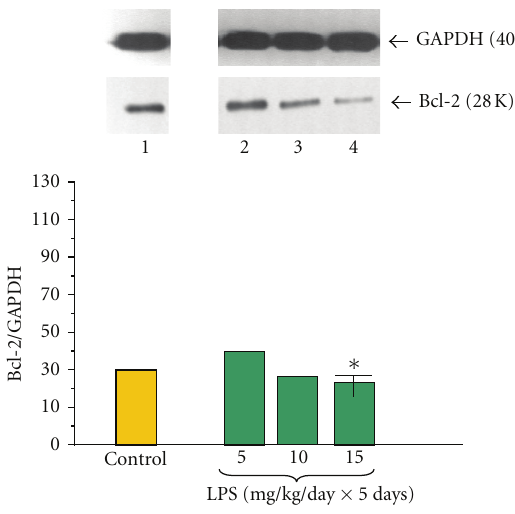
Figure 2: Western blot analysis of TLR4 protein level in the adult rat pancreatic acinar cells under basal conditions (lane 1), stimulated in vitro by caerulein at the dose of 10 − 8 M (lane 2), treated in the infant animals by lipopolysaccharide ( Escherichia coli ) at the doses of 5mg/kg/day × 5 days + caerulein 10 − 8 M (lane 3), 10 mg/kg/day × 5 days + caerulein 10 − 8 M (lane 4), and 15 mg/kg/day × 5 days + caerulein 10 − 8 M (lane 5) after 5 hours of incubation. Cross indicates significant ( P < 0 . 05) change, as compared to the control group. Asterisk indicates significant ( P < 0 . 05) change, as compared to the value obtained from the rats treated by increasing doses of LPS (10 or 15mg/kg/day × 5 days) in combination with caerulein (10 − 8 M), as compared to the caerulein (10 − 8 M) alone stimulation. The blots were stripped and probed with GAPDH to document equal protein loading. All